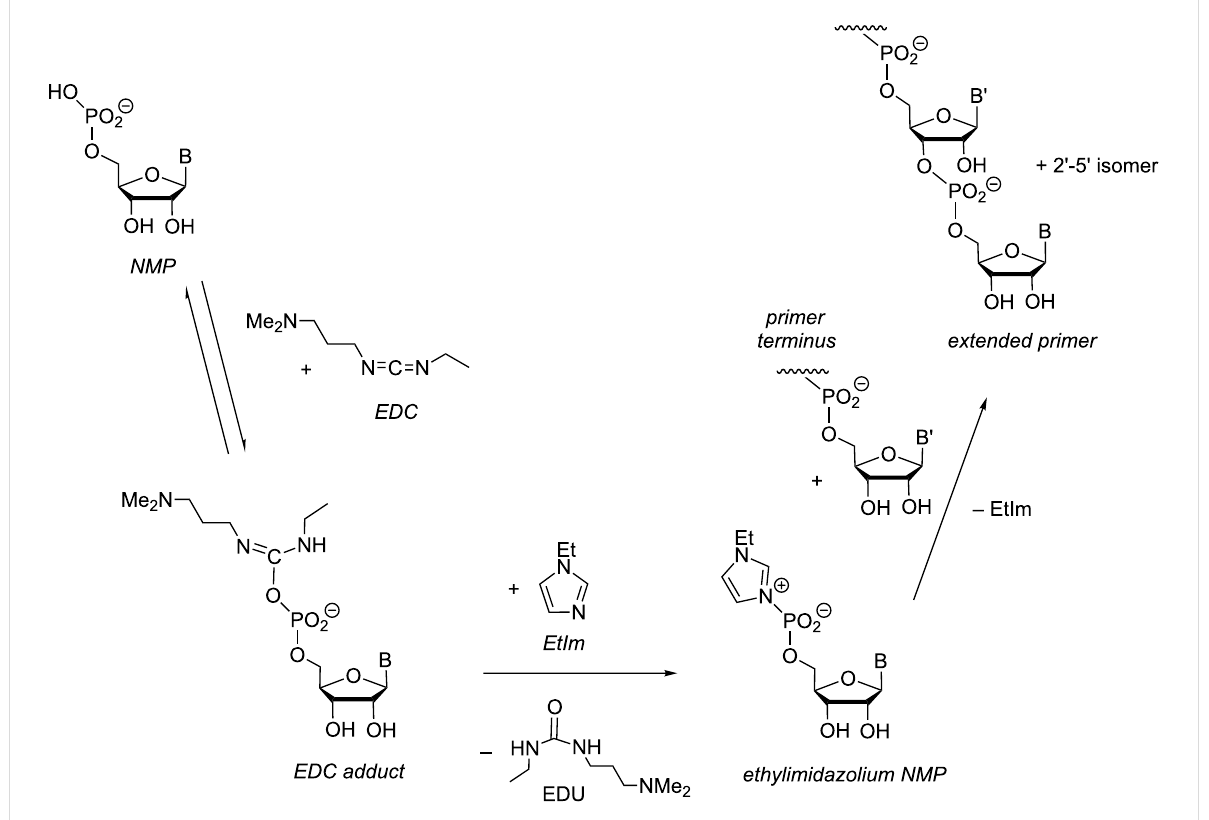
Figure 15: Proposed steps of enzyme-free primer extension with in situ activation, using the "general condensation buffer" containing EDC and 1-ethylimidazole as organocatalyst.